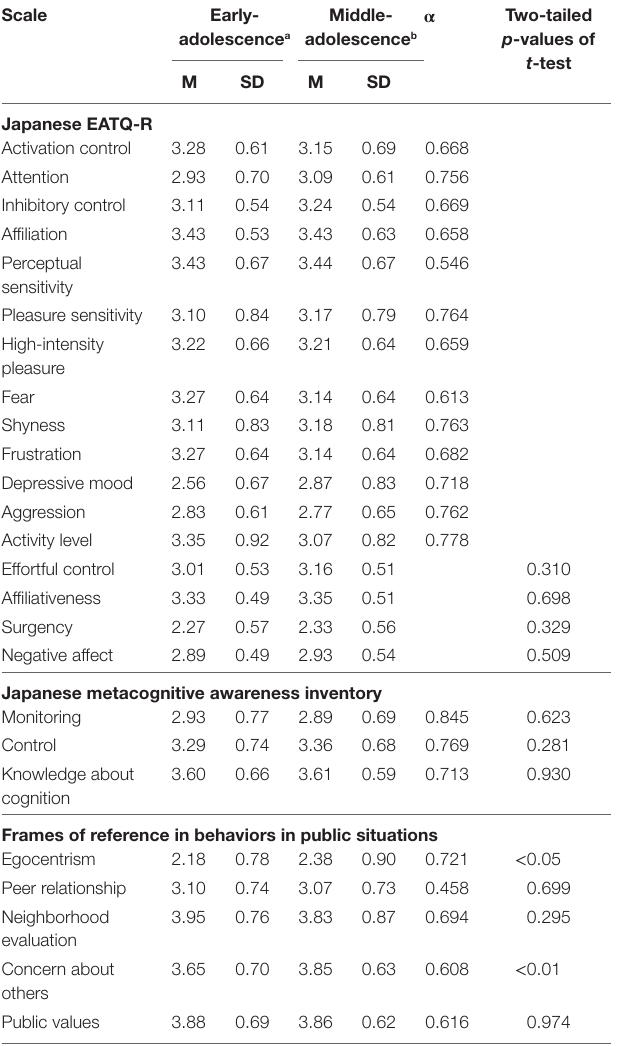
TaBle 5 | Average scores, SDs, and Cronbach’s α s for each group.